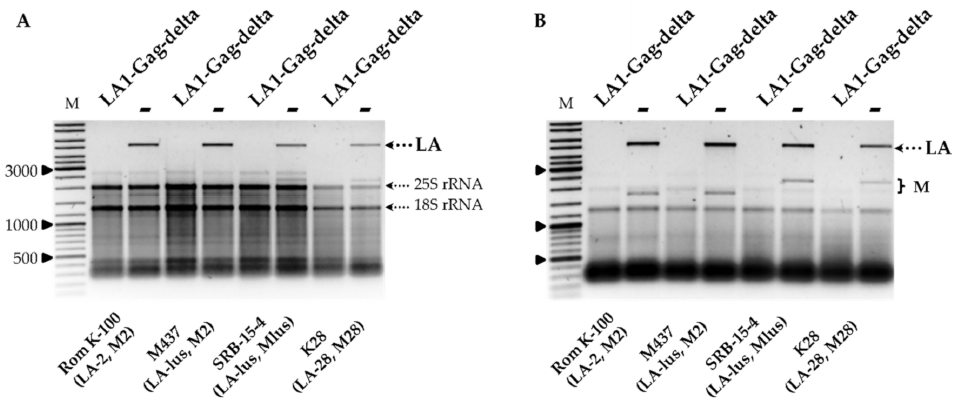
Figure 2. The impact of LA1-Gag-delta overexpression on the maintenance of LA and M dsRNAs in Rom K-100, SRB-15-4, M437 and K28 yeast strains. Agarose gel electrophoresis of total RNA ( A ) and dsRNA ( B ) isolated from respective yeast strain transformants; LA1-Gag-delta refers to samples transformed by truncated LA-1 Gag protein expression vector, − signifies control samples. M column is molecular size marker (GeneRuler DNA Ladder Mix, Thermo Scientific, Vilnius, Lithuania); yeast strains with corresponding genotypes are indicated below the pictures.